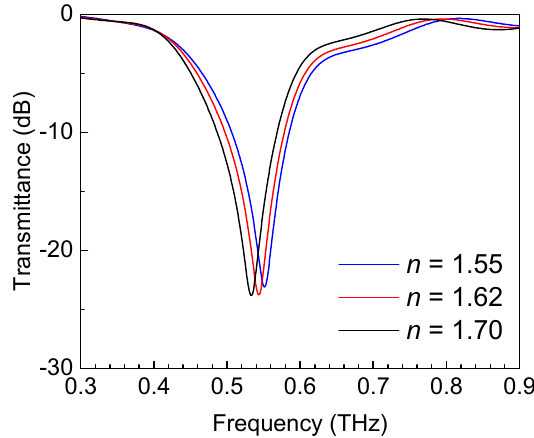
Figure 5. Simulated spectra of three metamaterial-coated LC cells at n = 1.55, 1.62, and 1.70. n is the refractive index of a dielectric layer that is deposited on the simulated PI-coated SRR.